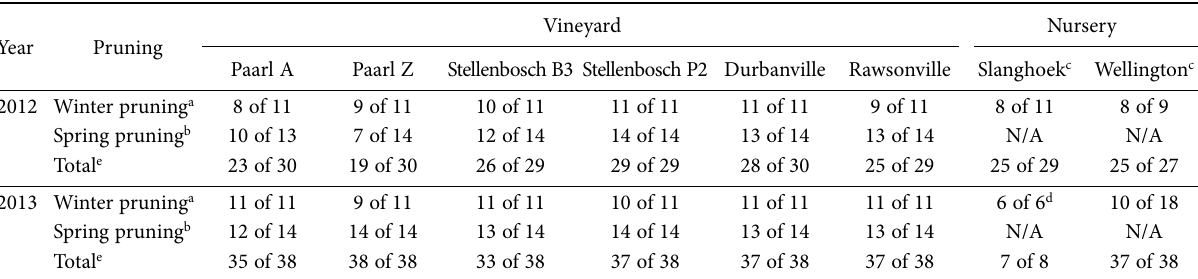
Table 5. Number of weeks with spore release events in the 2012 and 2013 trapping